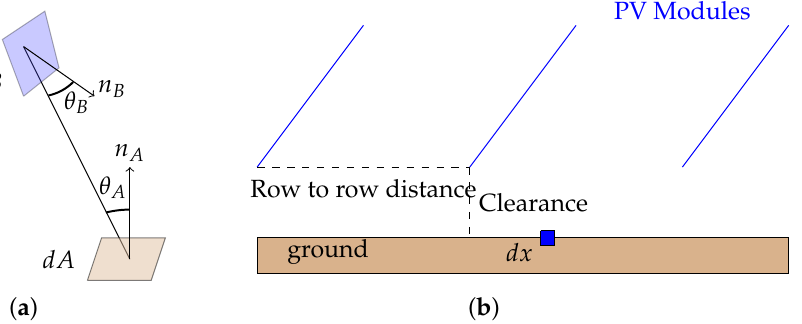
Figure 1. ( a ) Geometrical representation of segment dA and dB . ( b ) The two surfaces dA and dB are the ground segment dx and location on the module,